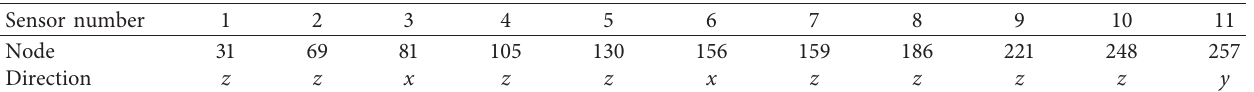
Table 6: Optimal sensor locations of DGSA.